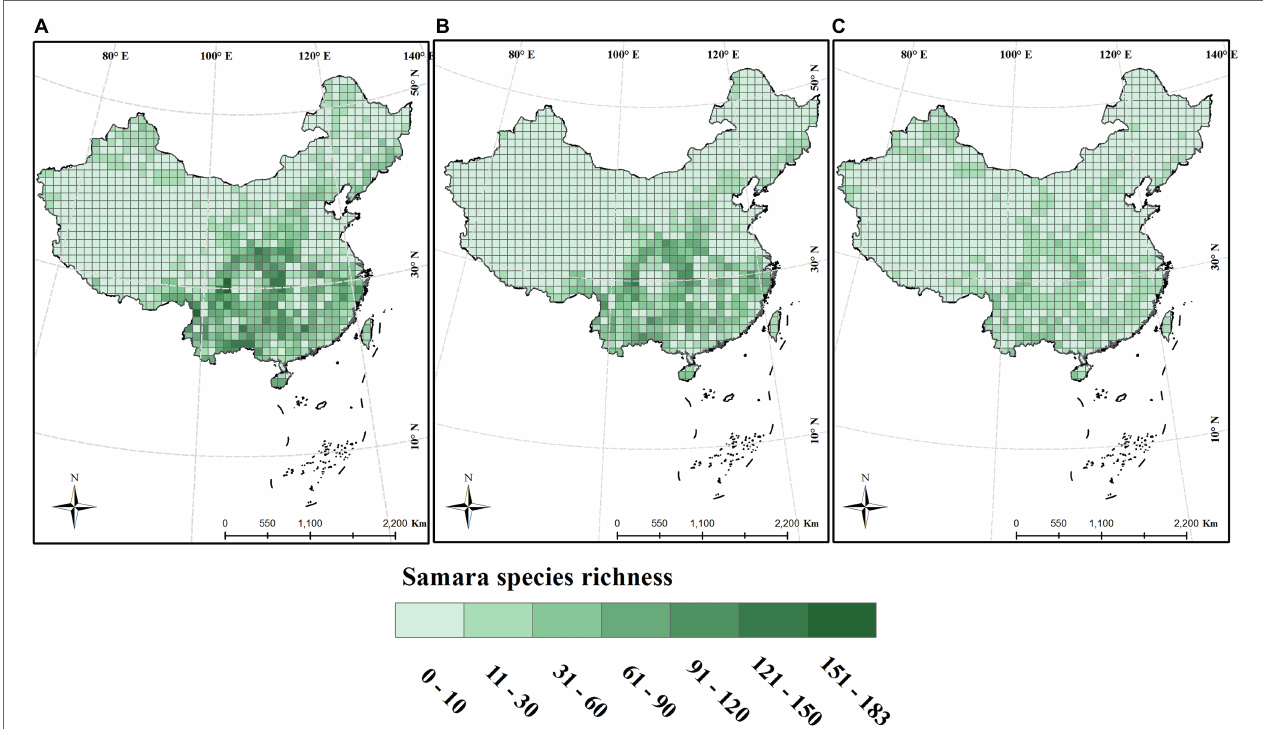
FIGURE 1 | Distribution of samara species richness across China. Species richness was calculated within a 100 × 100 km grid. (A) Total species; (B) woody species; (C) herbaceous